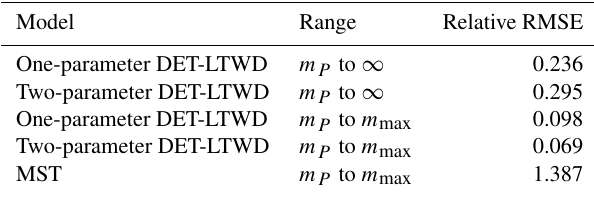
Table 8. The relative root mean squared error (RMSE) of the biomass density prediction of the 124 forest plots using the param- eters fitted via MLE to the mass size distribution. The table com- pares the results from the different DET-LTWD models and the MST model. The range column indicates the integration limits of the biomass density calculation. The DET-LTWD model assumes no maximum size and by default integrates out to infinity. This can be corrected in terms of the largest tree mass m max in the